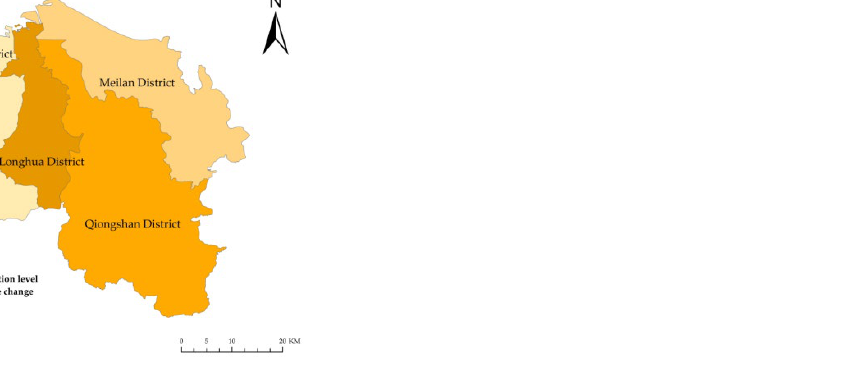
Figure 5. Sub-region contribution level of production space conversion and industrial-mining PS conversion in Haikou, China, from 2009 to 2018. conversion in Haikou, China, from 2009 to